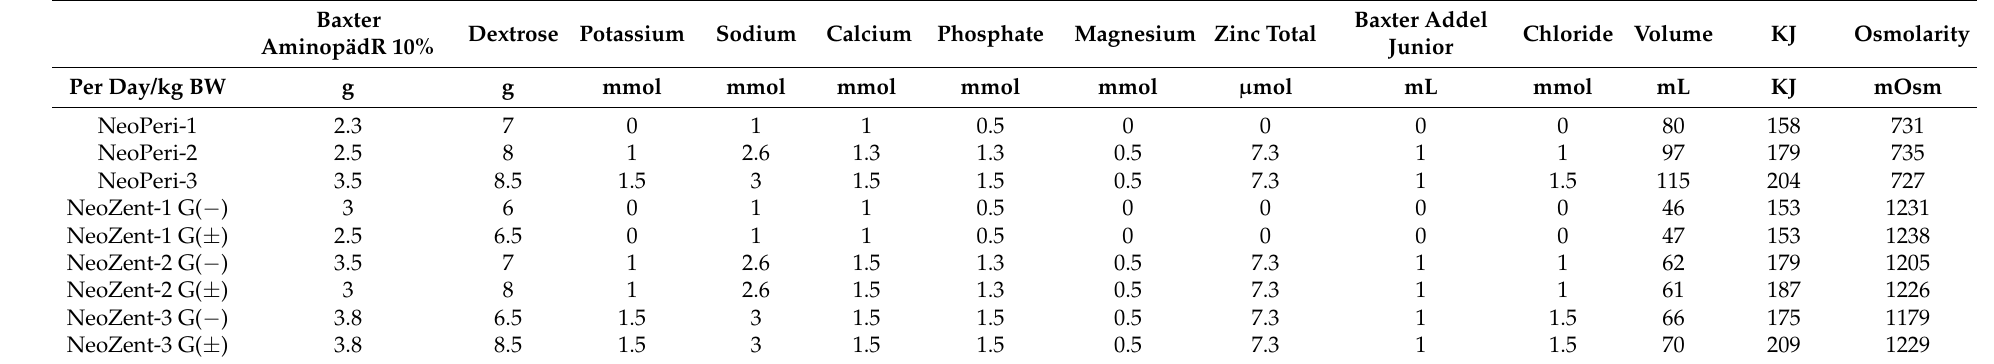
Table 2. ‘NeoPeri’ and ‘NeoZent’ solutions containing amino acids, glucose, electrolytes, and trace elements, supply per kg bodyweight per day.